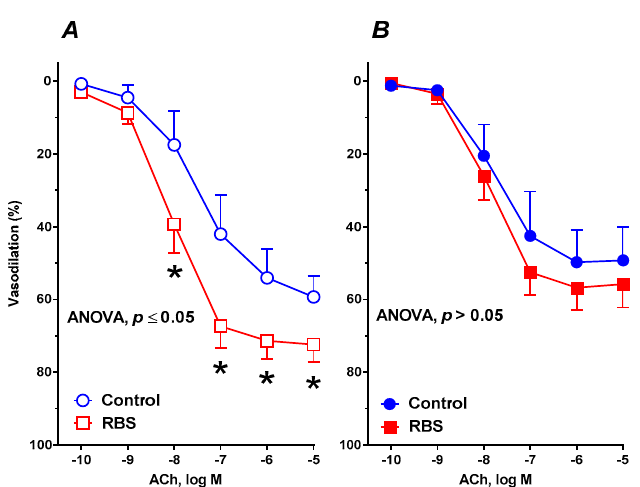
Figure 2. The influence of experimental diets on the vasodilator response to acetylcholine (ACh) in thoracic arteries isolated from WKYs ( A ) and SHRs ( B ). From 10 weeks of age, rats were fed a control diet and with a diet supplemented for 6 weeks with added 7% ground RBS. Results (mean ± SEM) are expressed as a percentage of the inhibition of the contraction induced by noradrenaline (1.5 ± 0.18 g), * p ≤ 0.05 (two-way ANOVA/Sidak’s), m = 6–8.